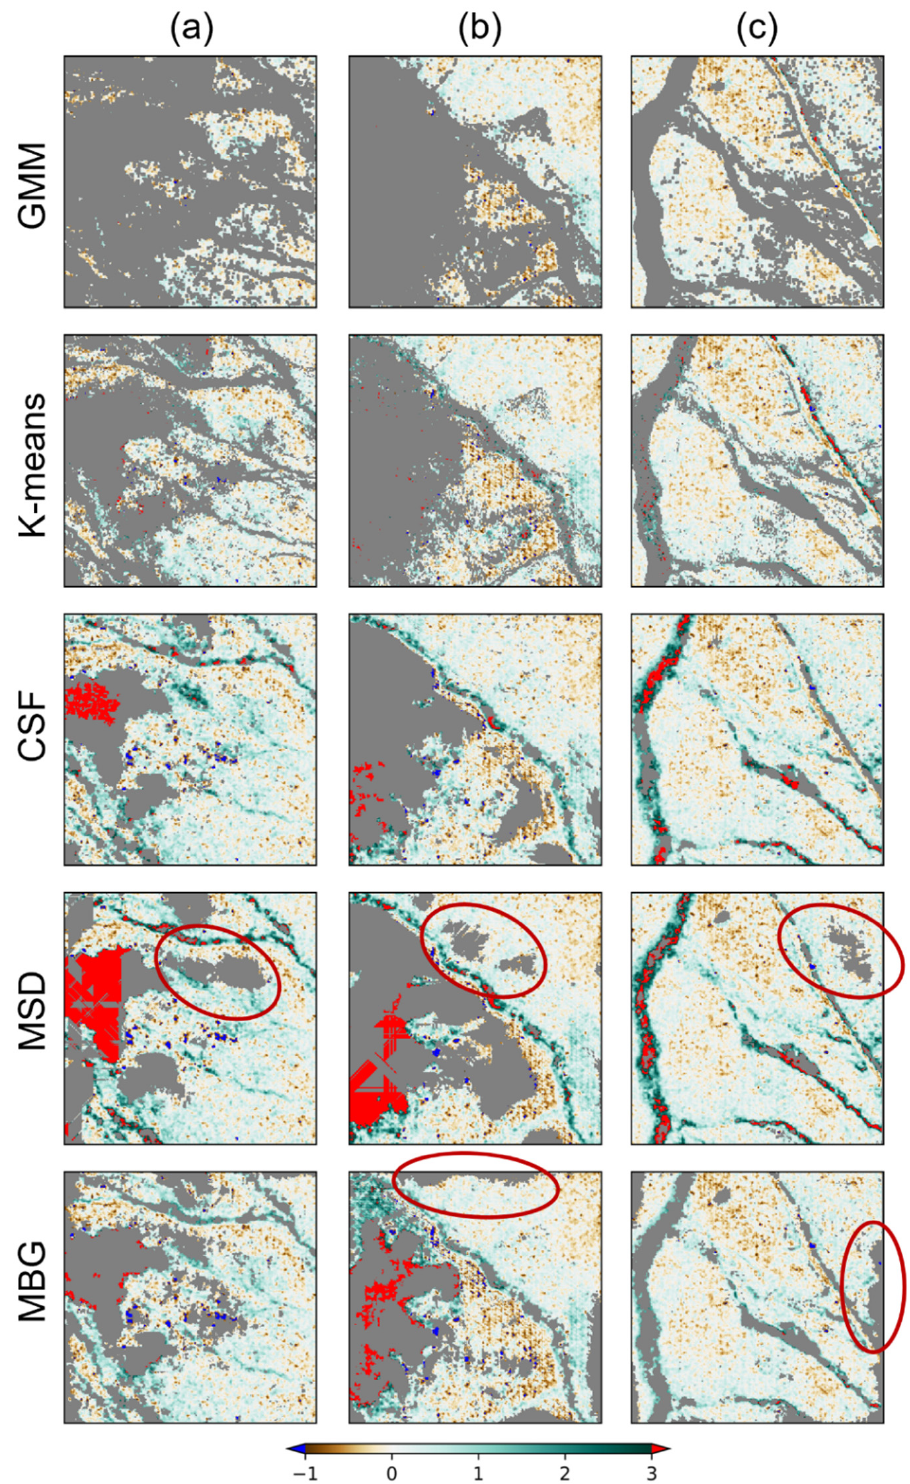
Figure 6. Ground masks derived from GMM, K-means, and three comparative ground filtering methods overlaid with DEM di ff erences (ArcticDEM − lidar-derived DTM), ( a – c ) correspond to Site-1, Site-2, and Site-3, respectively. The void areas displayed by grey color represent the non-ground locations in all ground masks. Positive DEM di ff erences indicate vegetated areas. Here, GMM represents pseudo-ground pixels re fi ned by both clustering membership probability >0.8 and morphological erosion.